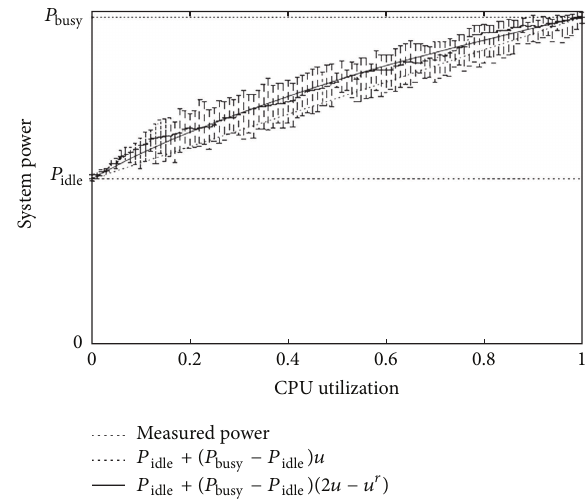
Figure 2: Power consumption and CPU utilization relationship